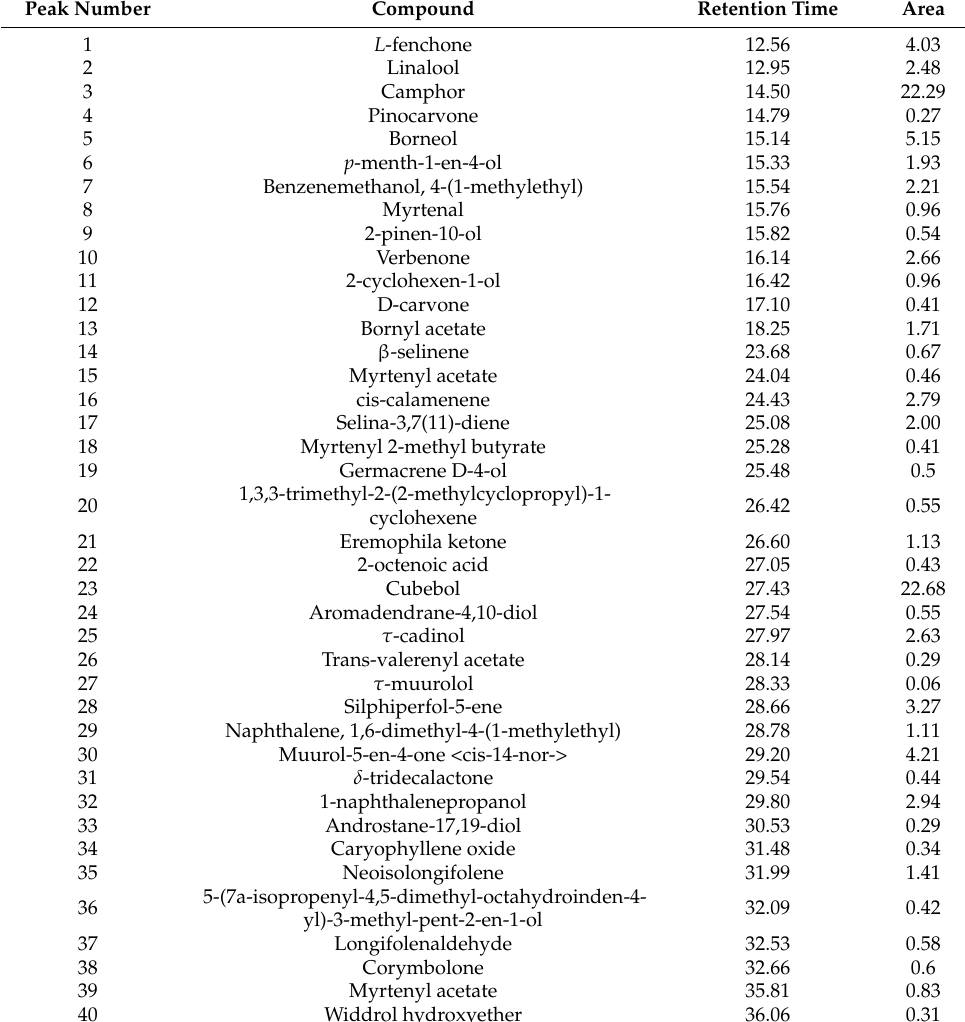
Table 2. Chemical composition of LSEO B